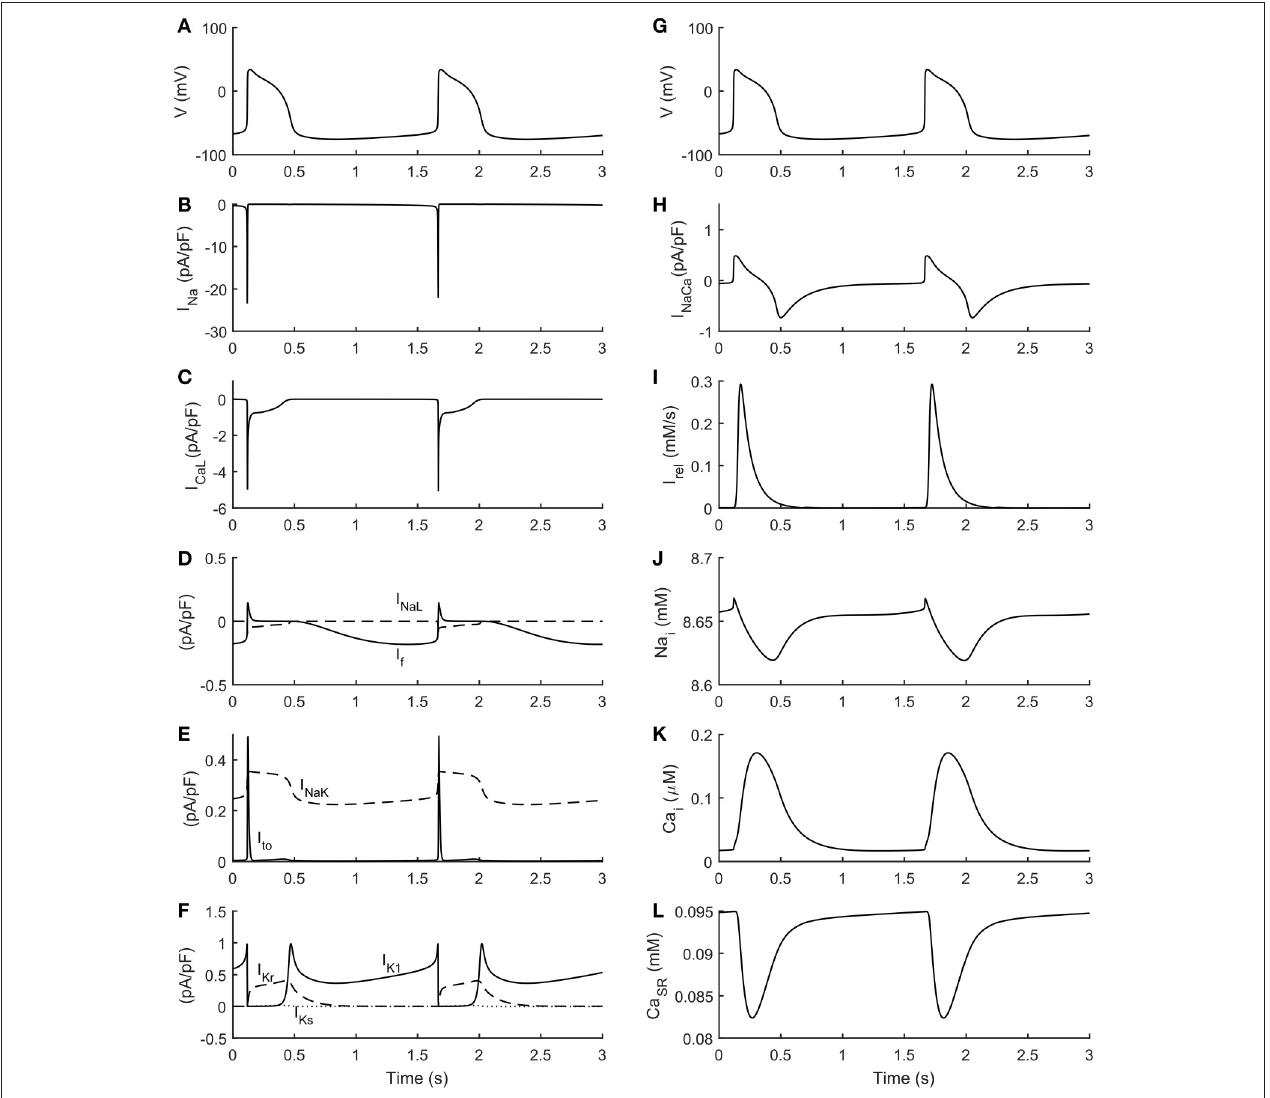
FIGURE 3 | Simulated spontaneous action potentials and ionic currents. (A,G) membrane potential. (B) Fast Na + current (I Na ). (C) L-type Ca 2 + current (I CaL ). (D) Funny current (I f ) and Late Na + current (I NaL ). (E) Transient outward K + current (I to ) and Na + /K + pump (I NaK ). (F) Rapid delayed (I Kr ), slow delayed (I Ks ) and inward (I K1 ) rectifier K + currents. (H) Na + /Ca 2 + exchanger (I NaCa ). (I) Release current from sarcoplasmic reticulum (I rel ). (J) Na + cytosolic concentration (Na i ). (K) Cytosolic Ca 2 + concentration (Ca i ). (L) Sarcoplasmic Ca 2 + concentration (Ca SR